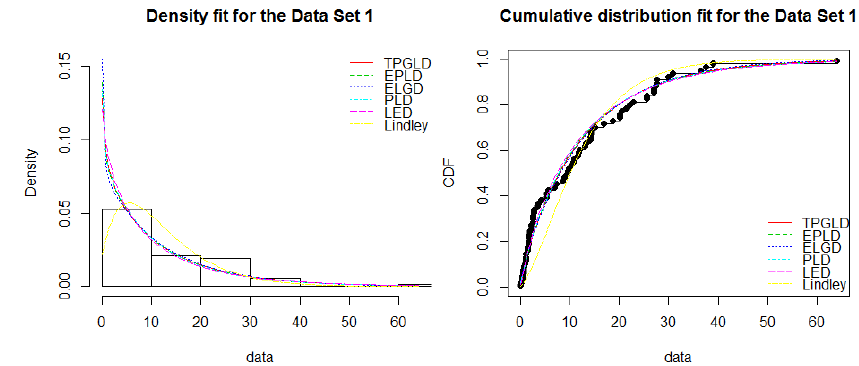
Figure 3 – Density and cumulative distribution fit for the Wheaton river flood